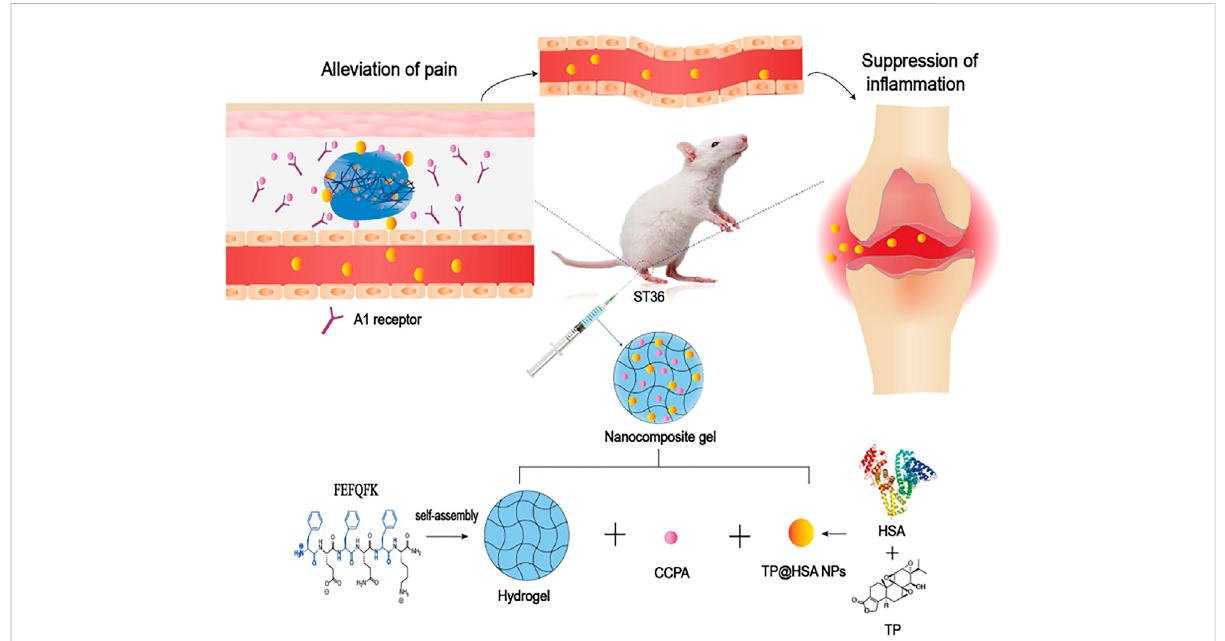
FIGURE 4 Schematicpresentationofthemechanismofnanocompositehydrogelappliedinthetreatmentofrheumatoidarthritis.CCPAandTP@HSANPs formed the acupoint nanocomposite hydrogel, which can simulate acupuncture to relieve pain through the stimulation of A1R, and realize the targeted deliver TP to suppress in fl ammation by regulating the expression level of in fl ammatory factors and maintaining the immune balance. Reproduced with permission from Ren et al. Journal of Nanobiotechnology; Published by BioMed Central,